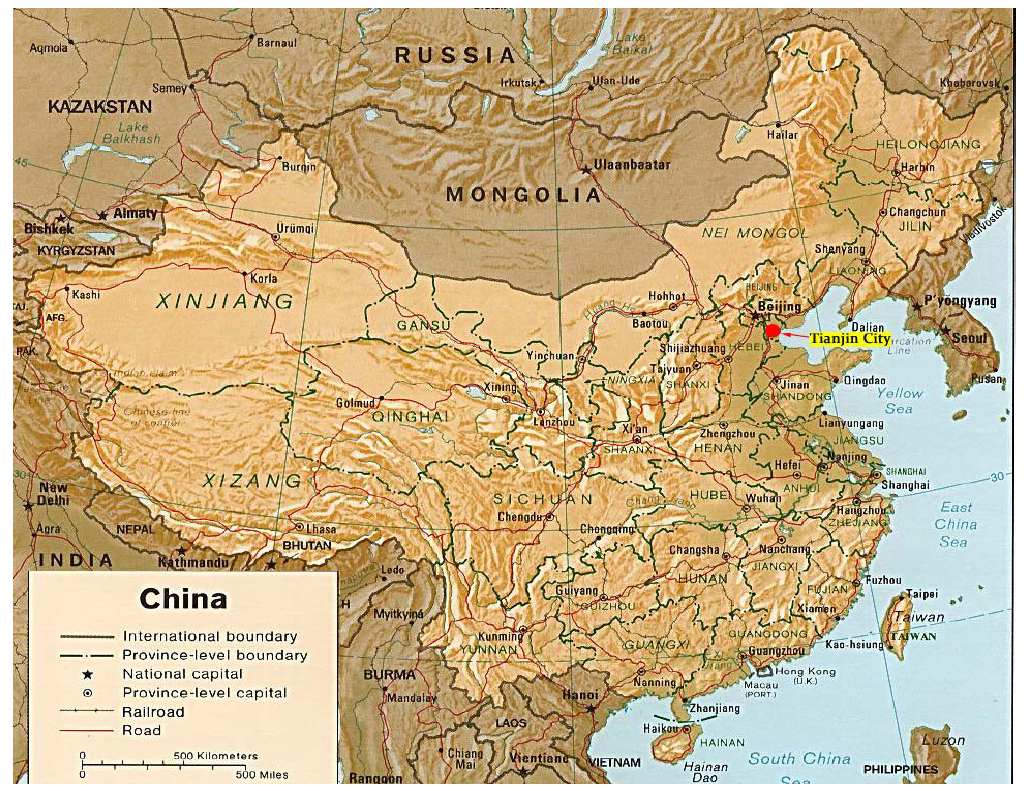
Figure 4. Map showing the location of Tianjin city in